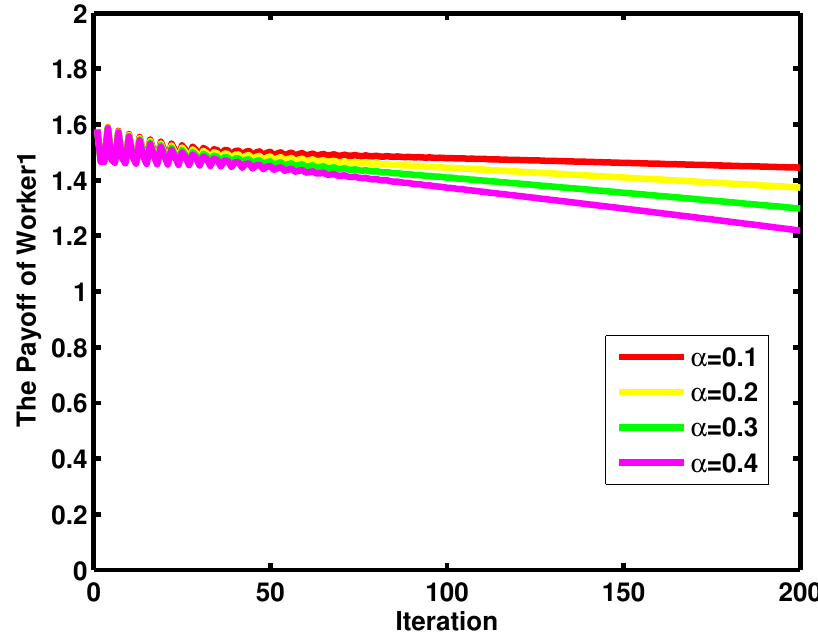
Figure 2. The payoff of worker 1 using ZD1 strategies with different α